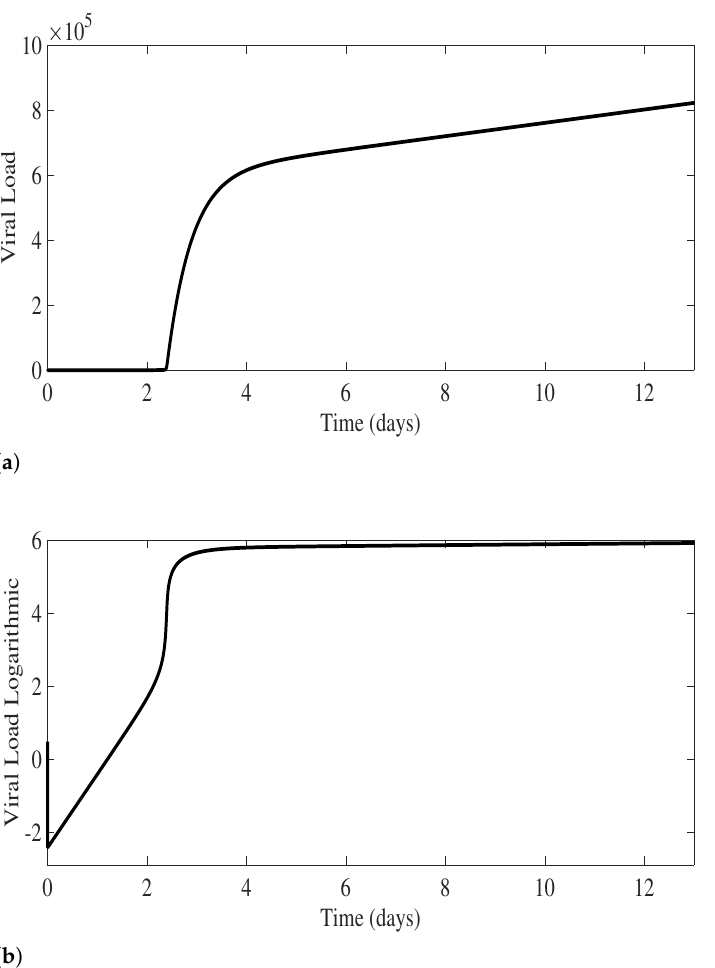
Figure 2. Free virus dynamics for primary infection prior to antibody production. The viral repli- cation dynamics are shown in natural scale ( a ) and in semi-logarithmic scale ( b ) with initial value S ( t 0 ) = π S / µ S , I ( t 0 ) = 0, and V ( t 0 ) = 3. Model parameters are shown in Table